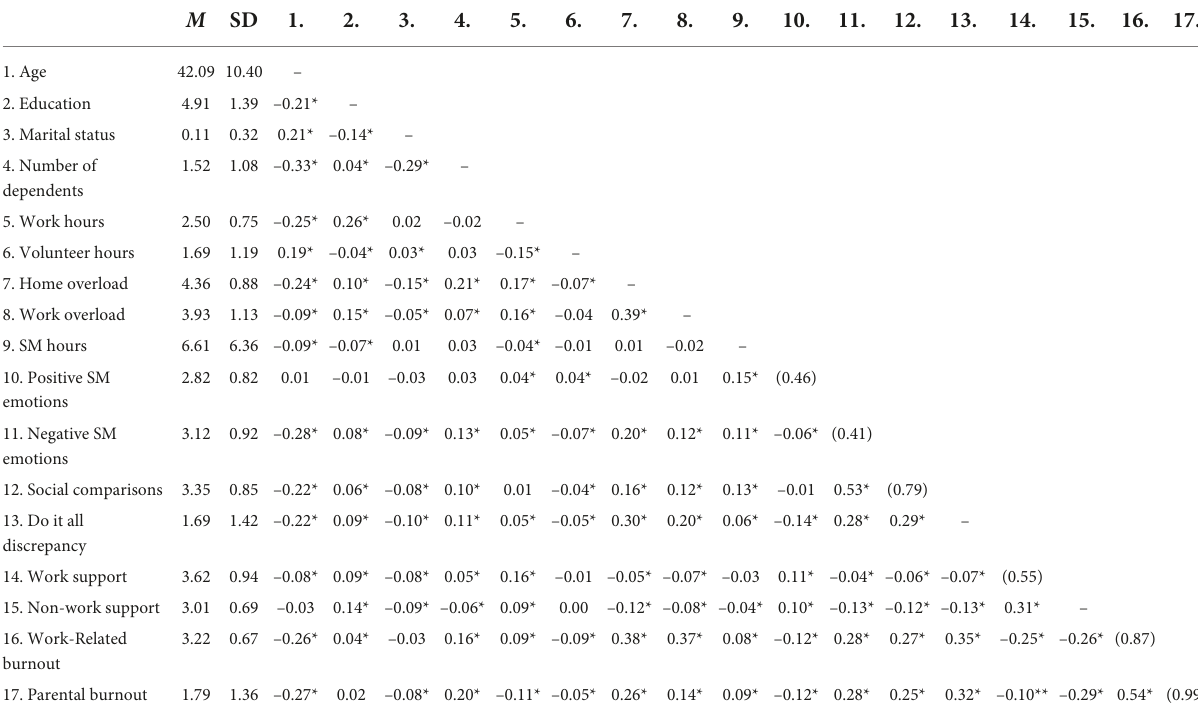
TABLE 1 Descriptive statistics and bivariate correlations for all study